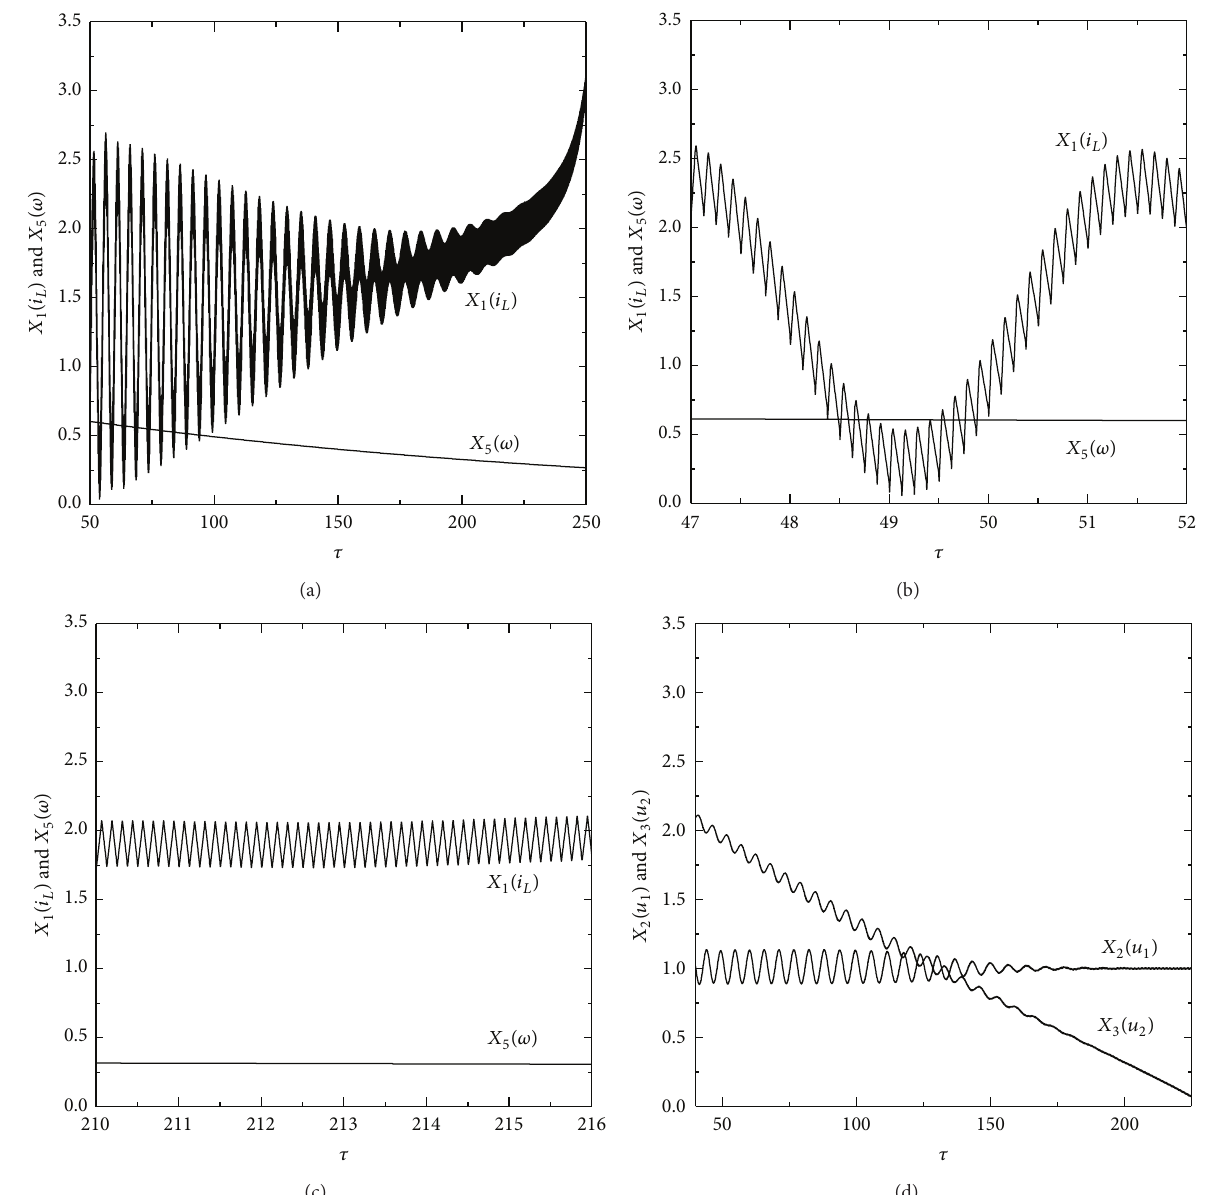
= 15 V, for (a) 𝑋 ref